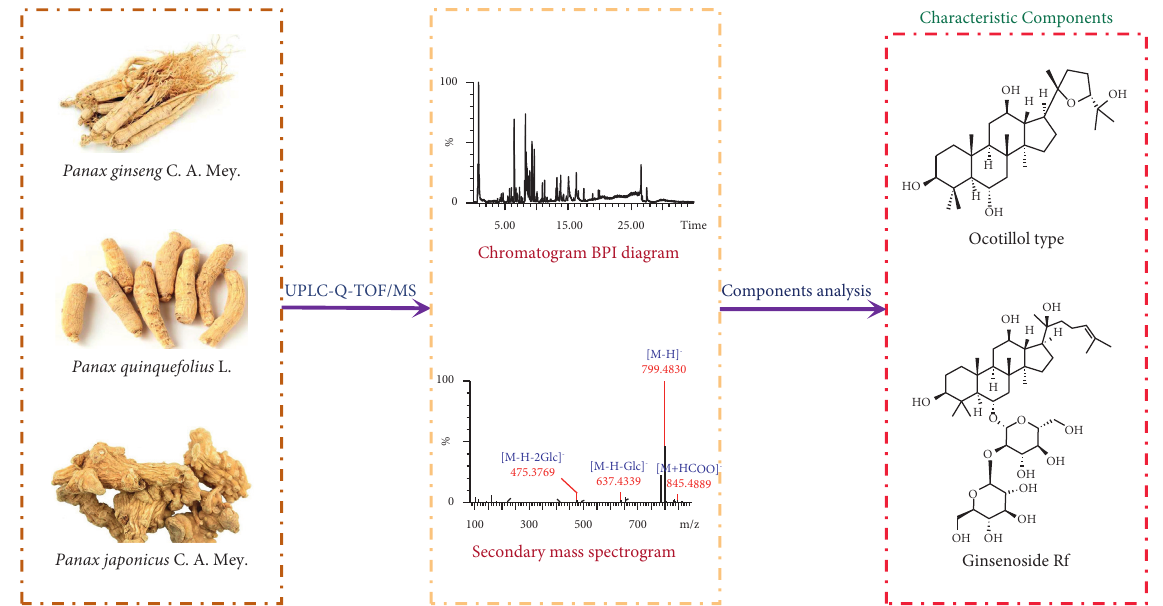
Figure 1: The rapid identification strategy of three traditional Chinese medicines in the genus Panax . Table 1: Detailed information of the tested PG, PQ, and PJ samples.